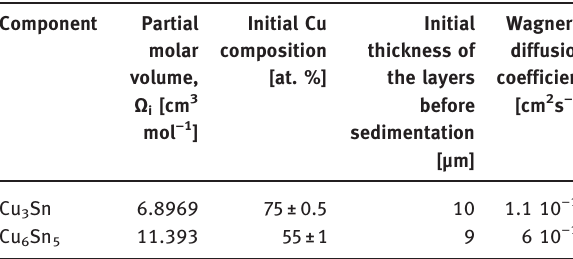
Table 1: The data used in simulations of Cu-Sn multiphase system during diffusion annealing and sedimentation at T = 200°C, angu- lar speed 140,000rev/min, r =